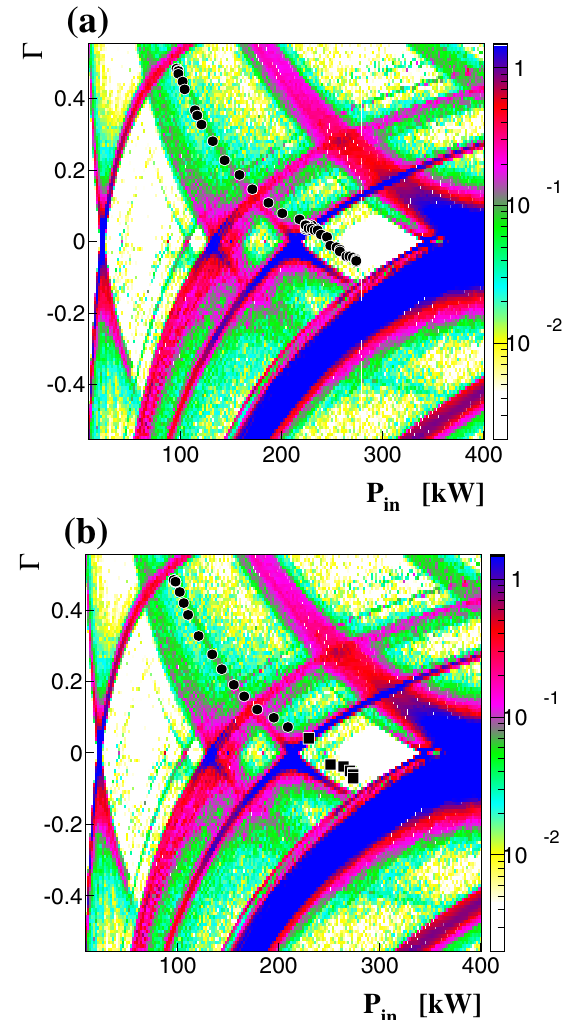
FIG. 8. (Color) Trajectories of the operating point of CavityM in the periods of (a) the beam recovery without the beam loading feedback for the early 30-five minutes in Fig. 6(b), and (b) the beam recovery with the beam loading feedback for the early 15 minutes in Fig. 6(d). The circles are data without the feedback, and the squares by using the feedback with the beam current above the threshold (0.9 A) for activating the feedback. The measurements of the circles and squares were recorded every 30